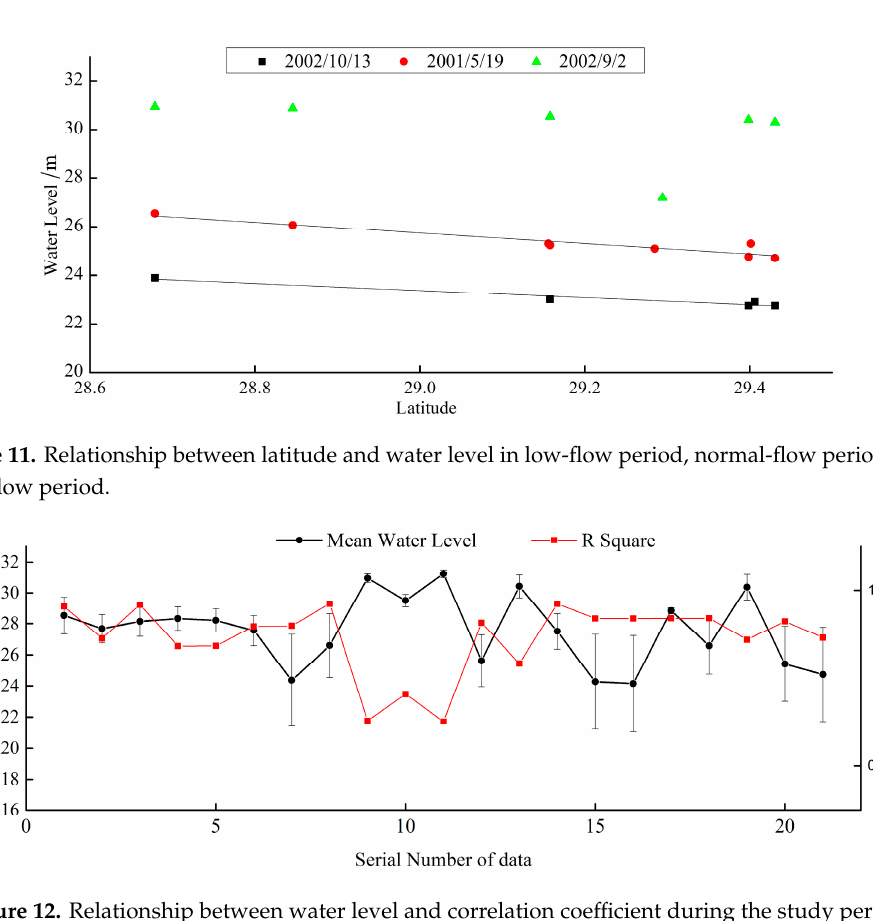
Table 2. Kriging interpolation with different semi-variogram models Kriging Method